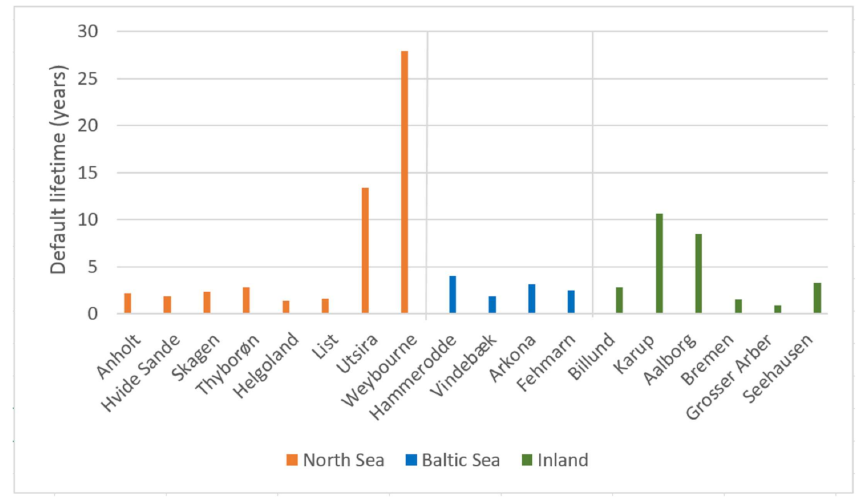
Figure 7. The lifetime in default operation for each station in the North Sea, Baltic Sea, and inland. The average lifetime for all North Sea stations was 6.7 years in default